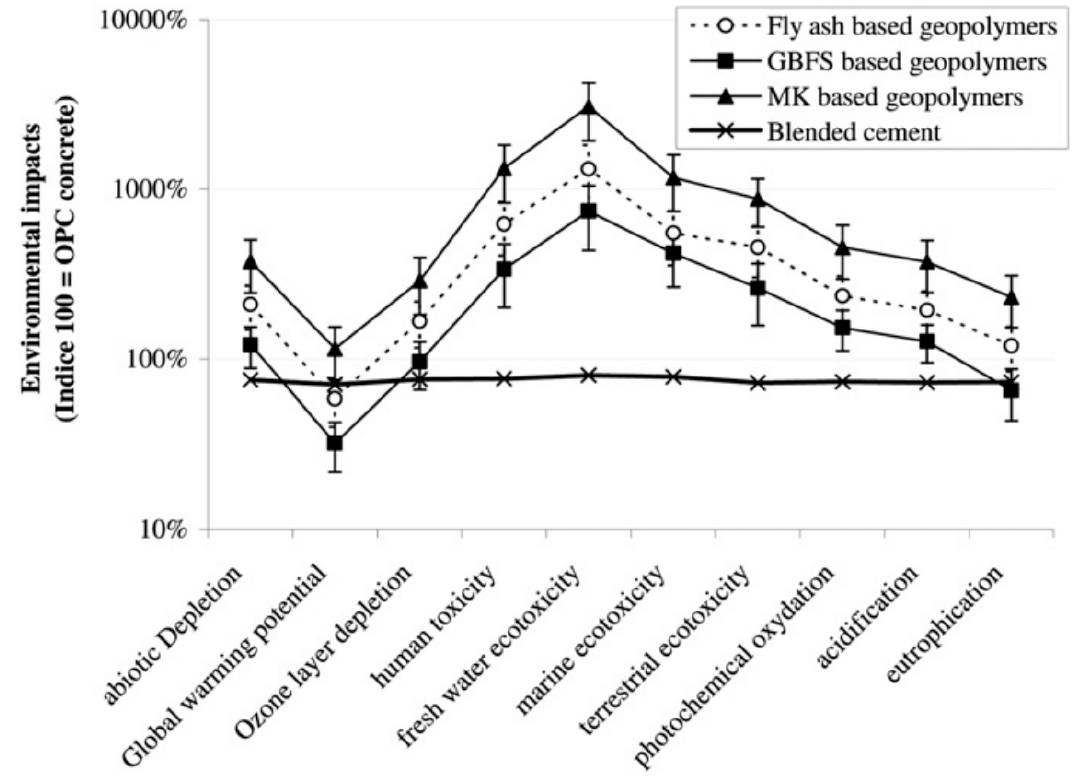
Figure 35. Comparison of different GPC containing different binders and OPC concrete [220].